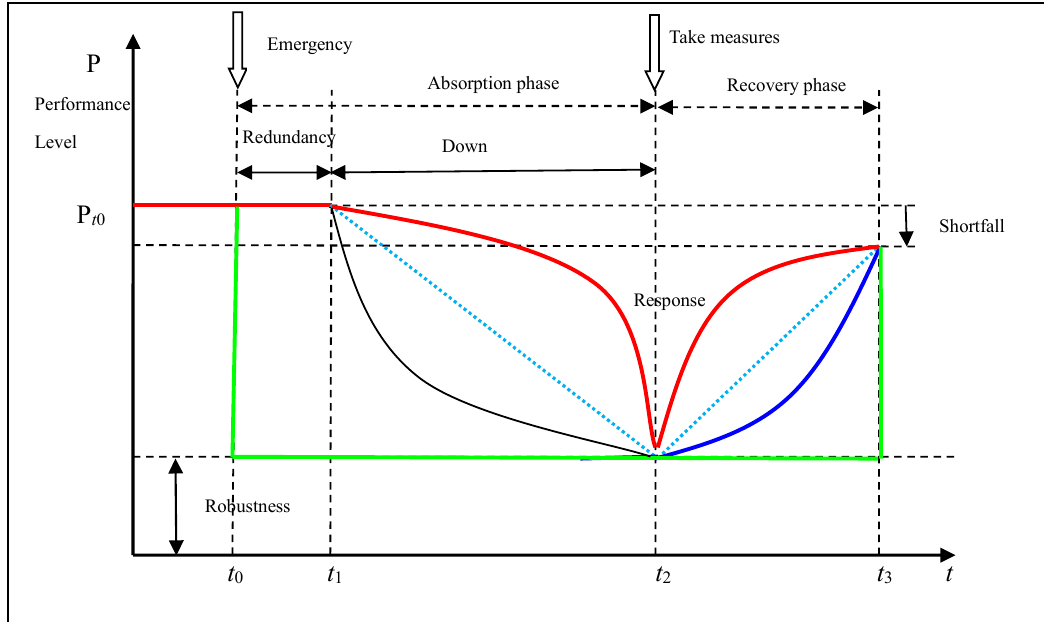
Figure 1. Measure of supply networks resilience.